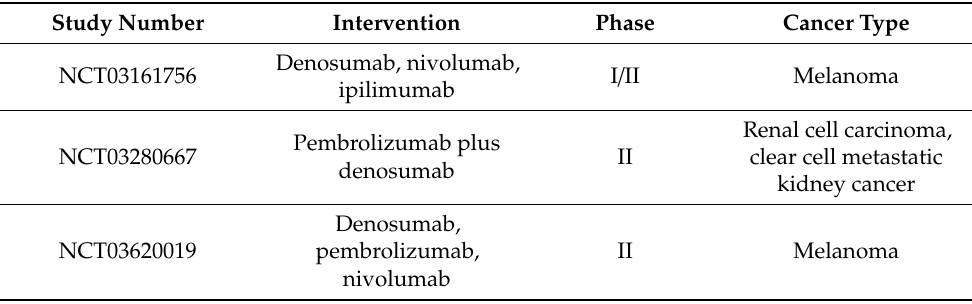
Table 2. Clinical studies with denosumab and checkpoint inhibitors in solid